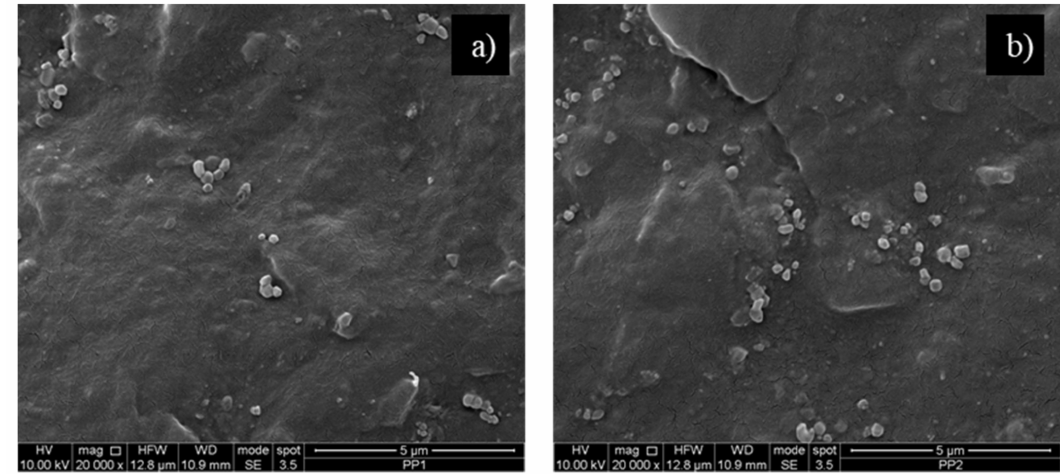
Figure 7. Scanning electron microscopy micrographs of the two polypropylene nanocomposites: ( a ) PP1 and ( b )